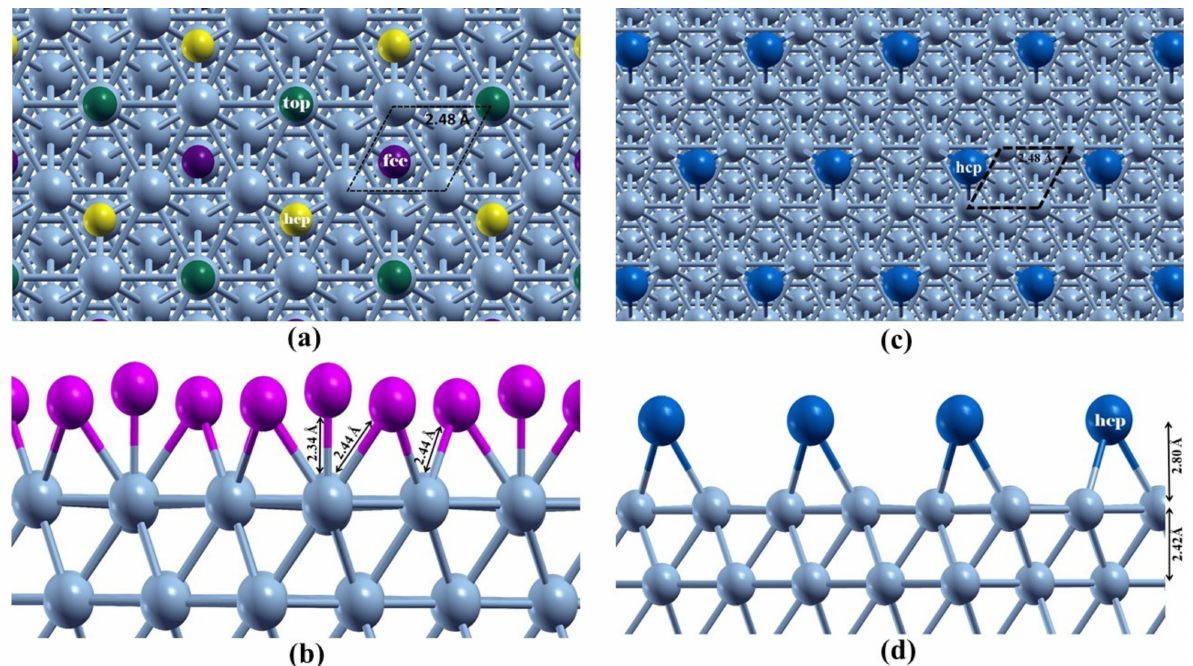
Figure 1. ( a ) Top view and ( b ) side view of Ni(111)/Al, where the grey atoms denote Ni, green, yellow, and purple denote the Al atoms at the top and the hollow sites of hcp and fcc, respectively; ( b ) the magenta atoms denote Al, ( c ) top and ( d ) side view of Ni(111)/Na, where the blue atoms denote Na at the hcp site.